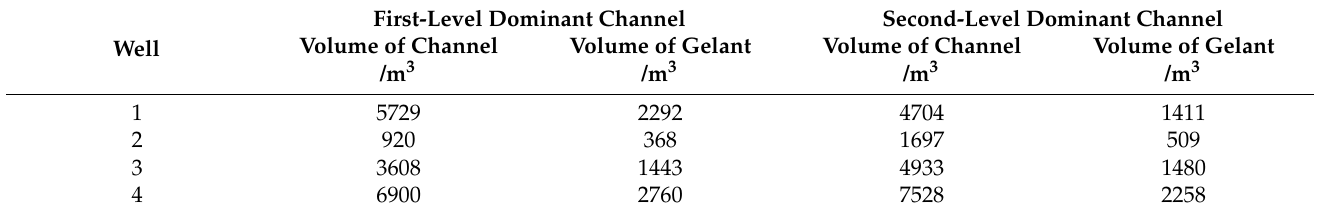
Table 2. Designed volume of gelant.